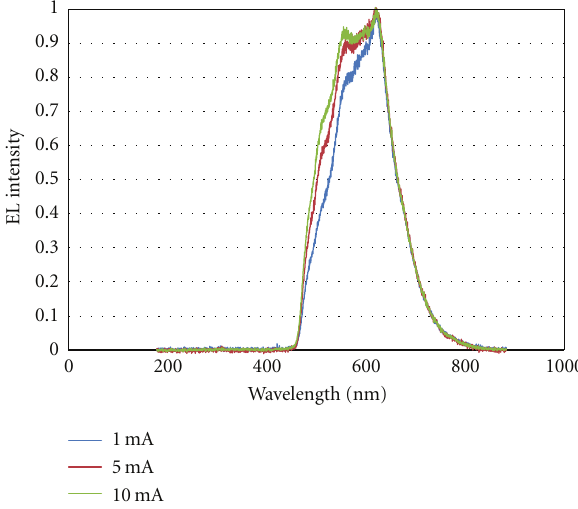
Figure 6: EL spectra in sample B. Injected currents are 1, 5, and